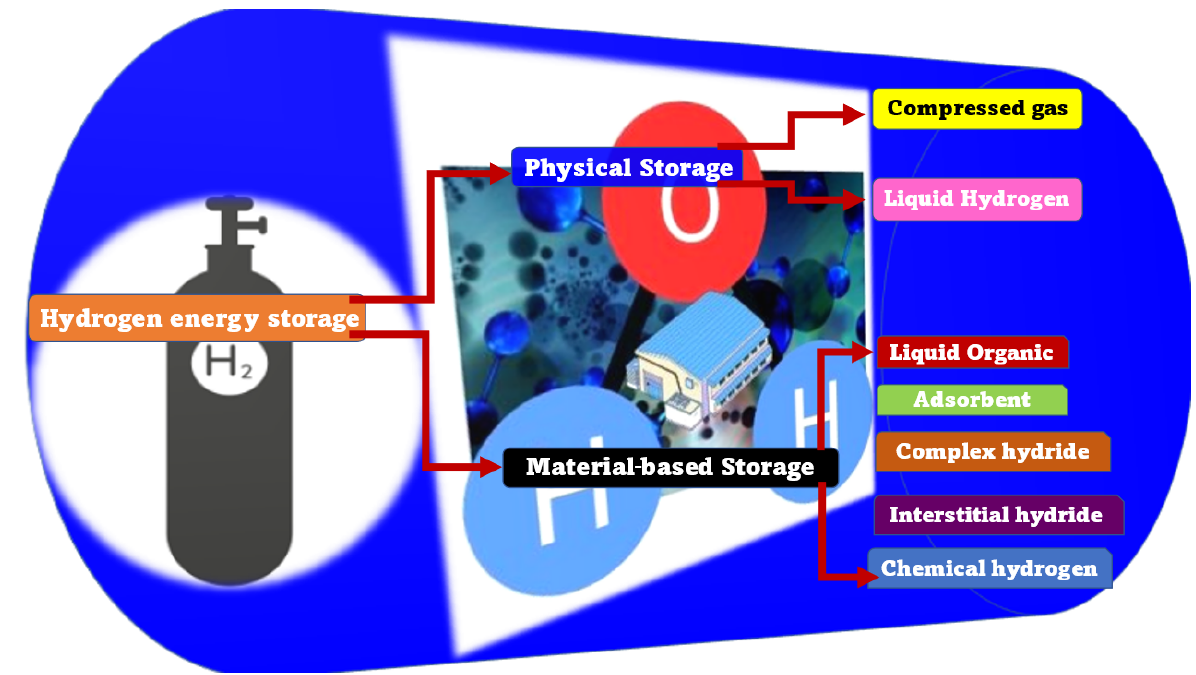
Figure 1. List of various storage methods for hydrogen storage.